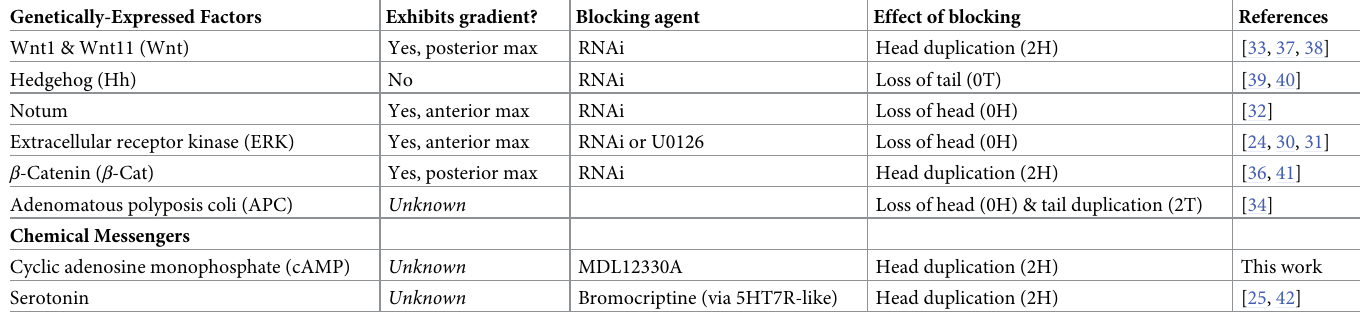
Table 1. A summary of gene products and chemical messengers that are known to alter regenerated planarian body-plan when inhibited by RNAi or pharmacologi- cal agents. Genetically-Expressed